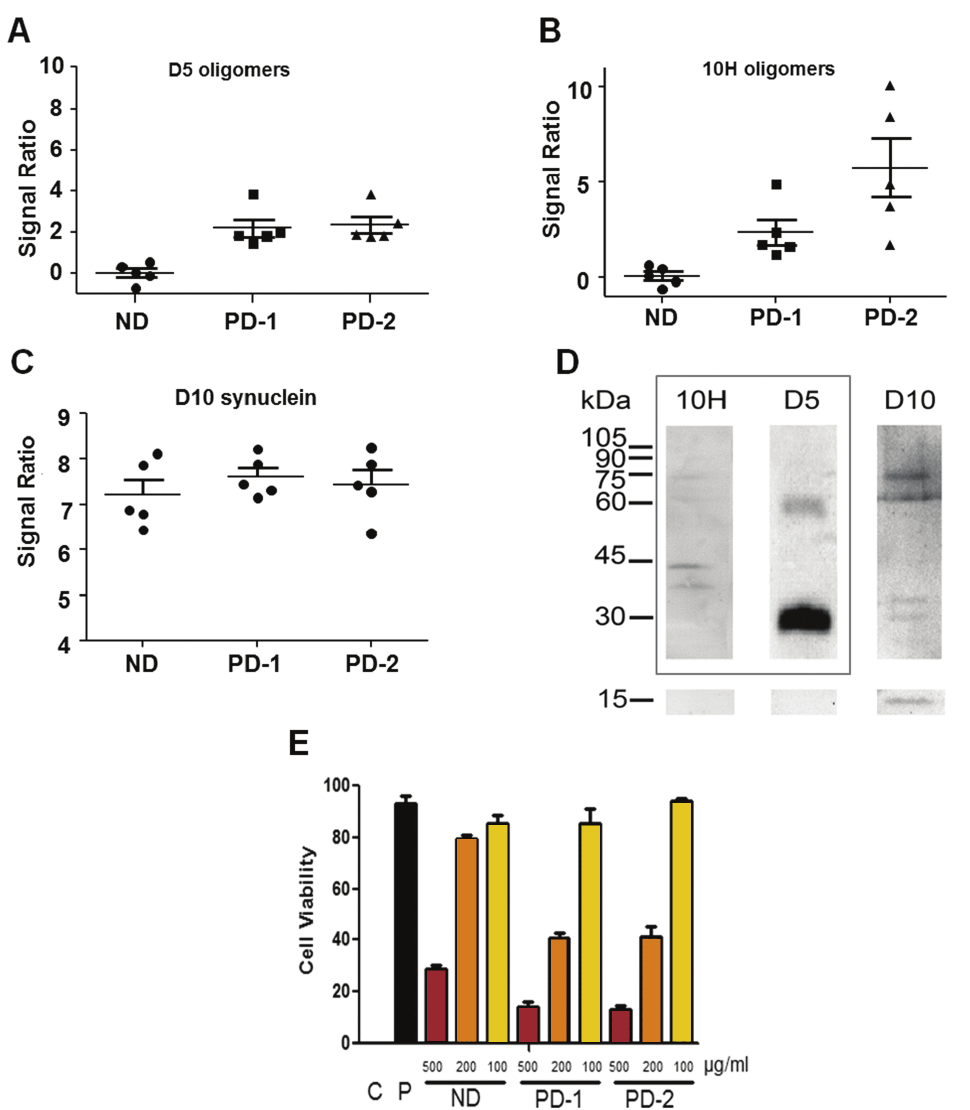
Figure 1. D5 and 10H reactive (cid:2)-synuclein oligomers in human patient brain samples and their cytotoxicity in SH-SY5Y cell model. ( A )–( C ) Relative amounts of D5 and 10H reactive (cid:2)-synuclein oligomers and D10 (cid:2)-synuclein (reacting with total (cid:2)-synuclein) present in different human PD and control brain homogenates; (D) Western blot of D5, 10H and D10 scFv binding specificity with (cid:2)-synuclein aggregates (adapted from [20,21]); ( E ) Toxicity of homogenized brain tissue from PD-1, PD-2 and ND control brain pools towards SH-SY5Y cells. C is a SHSY5Y cell-free control corresponding to 0% cell viability limit. P is a healthy SHSY5Y cell control corresponding to 100% cell viability